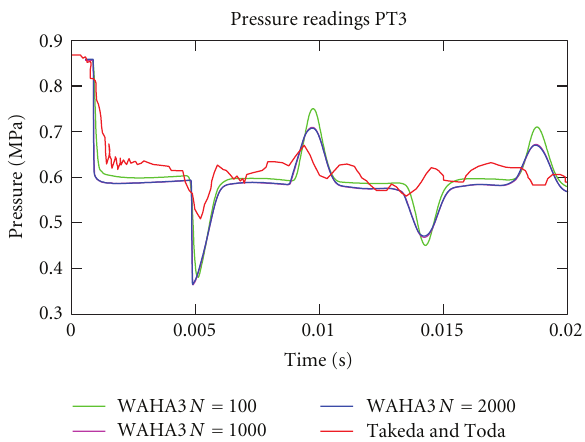
Figure 6: Influence of the number of volumes diving the pipe’s